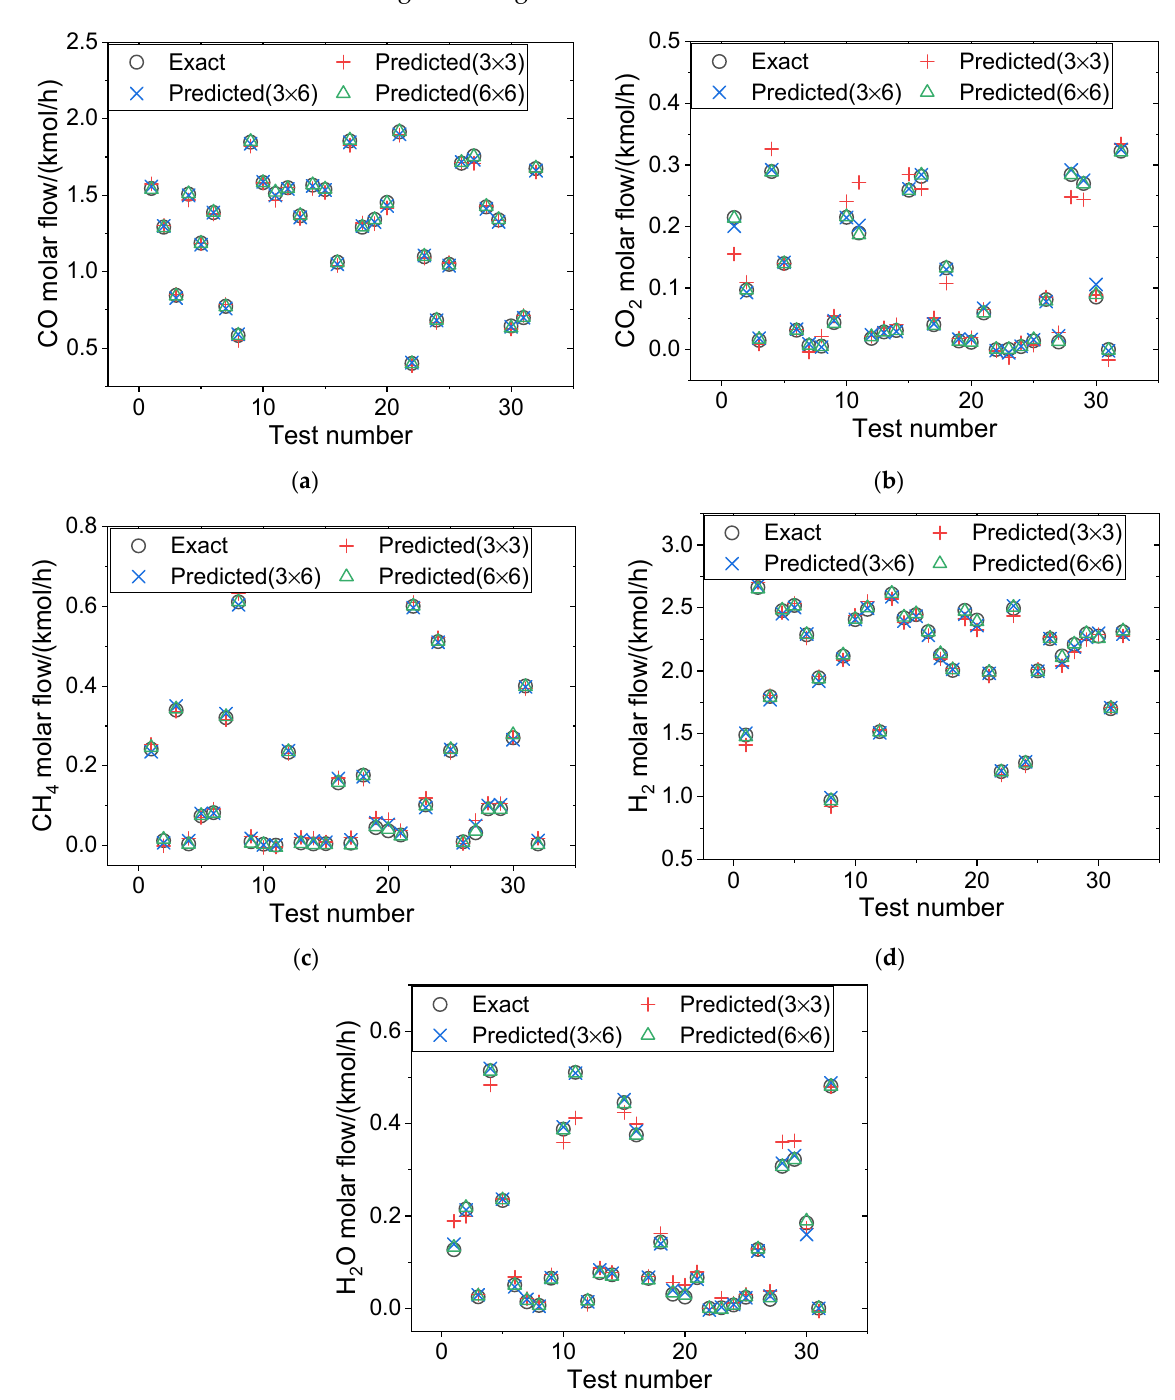
10 of 16 Figure 5. Regression performances of the training process with different numbers of neurons: ( a ) 3 × 3; ( b ) 3 × 6; ( c ) 6 × 6. During the ANN establishment process, though different numbers of neuron nodes in hidden layers are used, the samples are kept the same in these cases. Therefore, the performances of these established ANN models can be compared. It is seen that the cor- relation coefficient becomes higher when the node number increases, regardless of what the process is. When the neuron number of hidden layers are chosen as (3, 3), the correla- tion coefficient in the training process is 0.99605. When the neuron numbers increase to (6, 6) in the hidden layers, the correlation coefficient reaches 0.99996 in the training pro- cess. Increasing the neuron numbers is certainly beneficial to improve the accuracy of the ANN model. This can be demonstrated by the correlation coefficient in the test process. As these ANN models have quite a high performance, they are used to predict the BRM